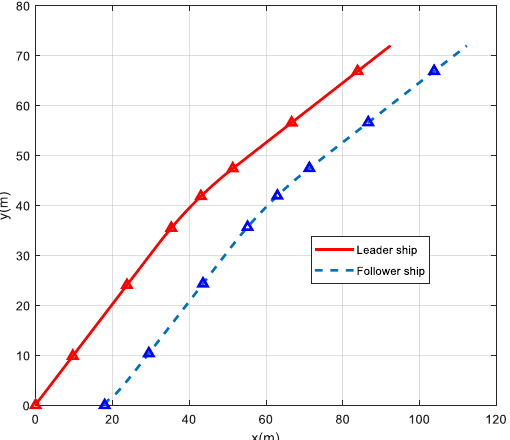
Figure 11. The tracking performance of synchronization control with changes in velocities and course.